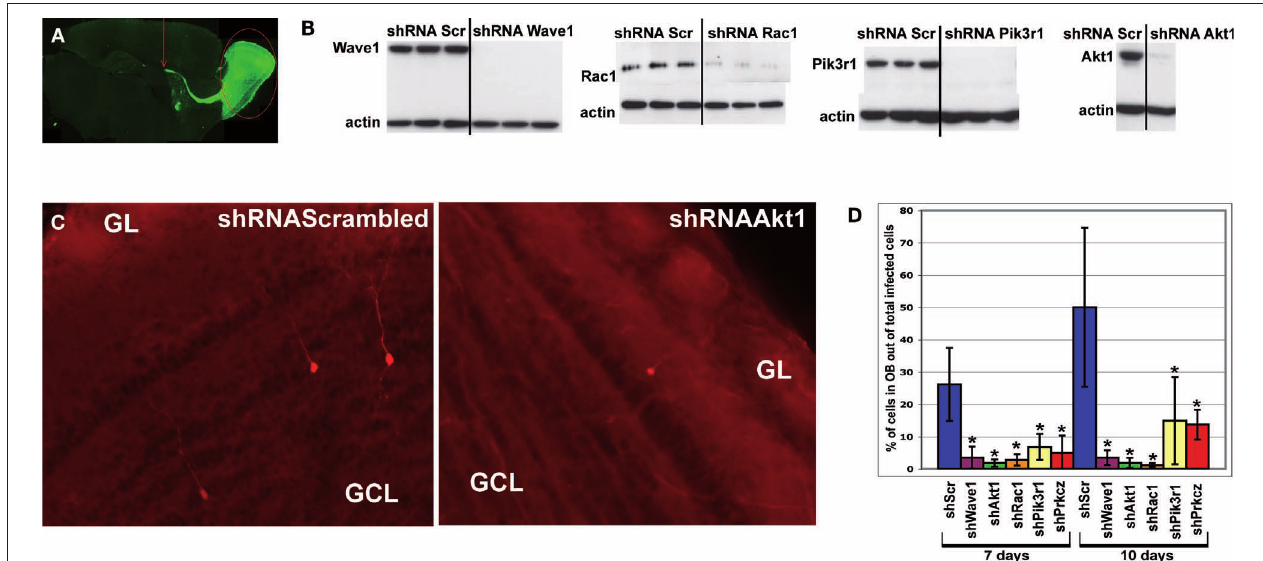
viruses. Fewer infected cells were found in OB of shRNAAkt1-injected animals. (D) Percentage of infected cells in olfactory bulb relative to total number